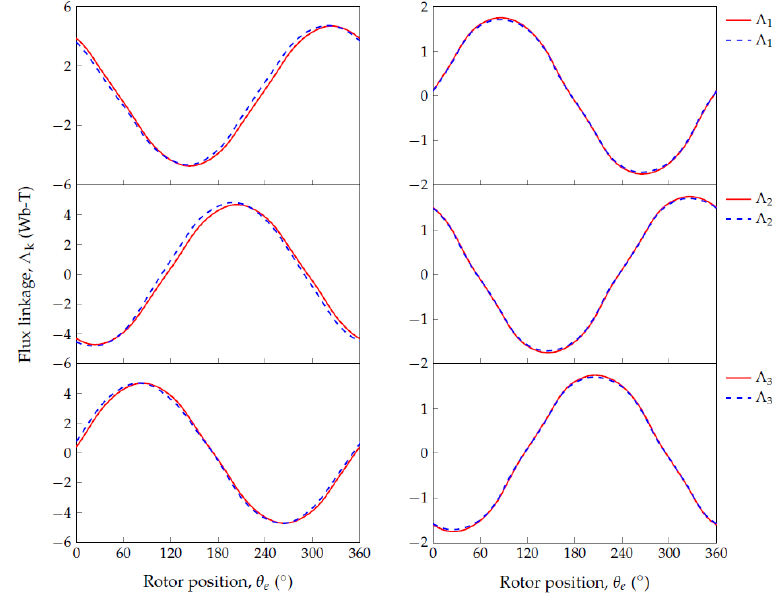
Figure 12. WF-FMM phase flux linkages of ( left ) WF-FSM and ( right ) DC-VRM versus rotor positions at rated currents (phase and field) and an operating current angle α = 90 ◦ . Proposed model—continuous line and Ansys–Maxwell—dashed